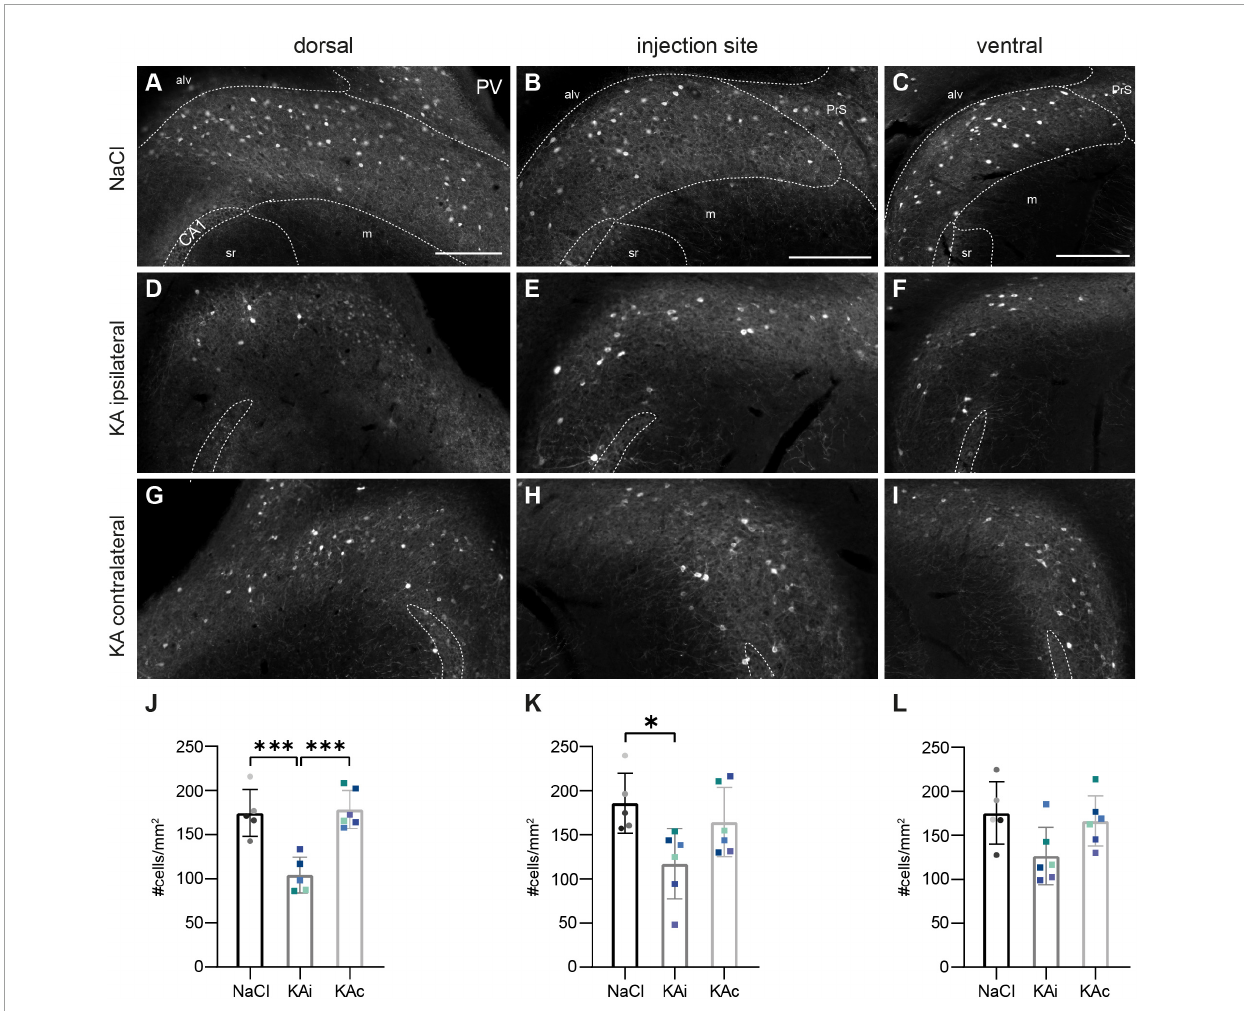
FIGURE3 Parvalbumin (PV)-positive interneurons are reduced in the ipsilateral subiculum 21 days after kainate (KA). Representative sections immunostained for PV in control mice (A–C) and 21 days after KA injection (D–I) . The localization of the CA1 pyramidal cell layer is indicated. The borders of the subicular pyramidal cell layer toward the alveus (alv) and the molecular layer (m) are delineated as dashed lines according the brain atlas (Franklin and Paxinos, 2008). (A) Dorsal subiculum after NaCl injection. PV + cells are evenly distributed throughout the pyramidal cell layer of the proximal and distal subiculum and PV + fibers form a dense plexus. (B,C) Similar pattern at the level of the injection site (B) and further ventral (C) . (D) Ipsilateral subiculum 21 days after KA, dorsal position. PV + somata and PV + fibers are strongly diminished, mainly in the part of the pyramidal cell layer adjacent to the molecular layer. (E) Similar pattern for the level of the injection site and further ventral (F) . (G–I) Contralateral subiculum 21 days after KA. The density of PV + interneurons is comparable to controls. (J–L) Quantification of PV + cells in the subiculum of NaCl-injected mice, ipsi- and contralateral subiculum of KA-injected mice 21 days after injection. Individual mice are color-coded, bars show means (cells/mm 2 ) with standard deviation (SD). (J) Reduced density of PV + cells in the ipsilateral (KAi) but not contralateral dorsal subiculum (KAc) (one-way ANOVA: p = 0.0002, Tukey’s multiple comparison test NaCl–KAi: p = 0.0008; KAi–KAc: p = 0.0004). (K) Reduction of PV + cell density in the ipsilateral subiculum at the injection site (one-way ANOVA: p = 0.026, Tukey’s multiple comparison test NaCl–KAi: p = 0.025). (L) The effect on KA on PV